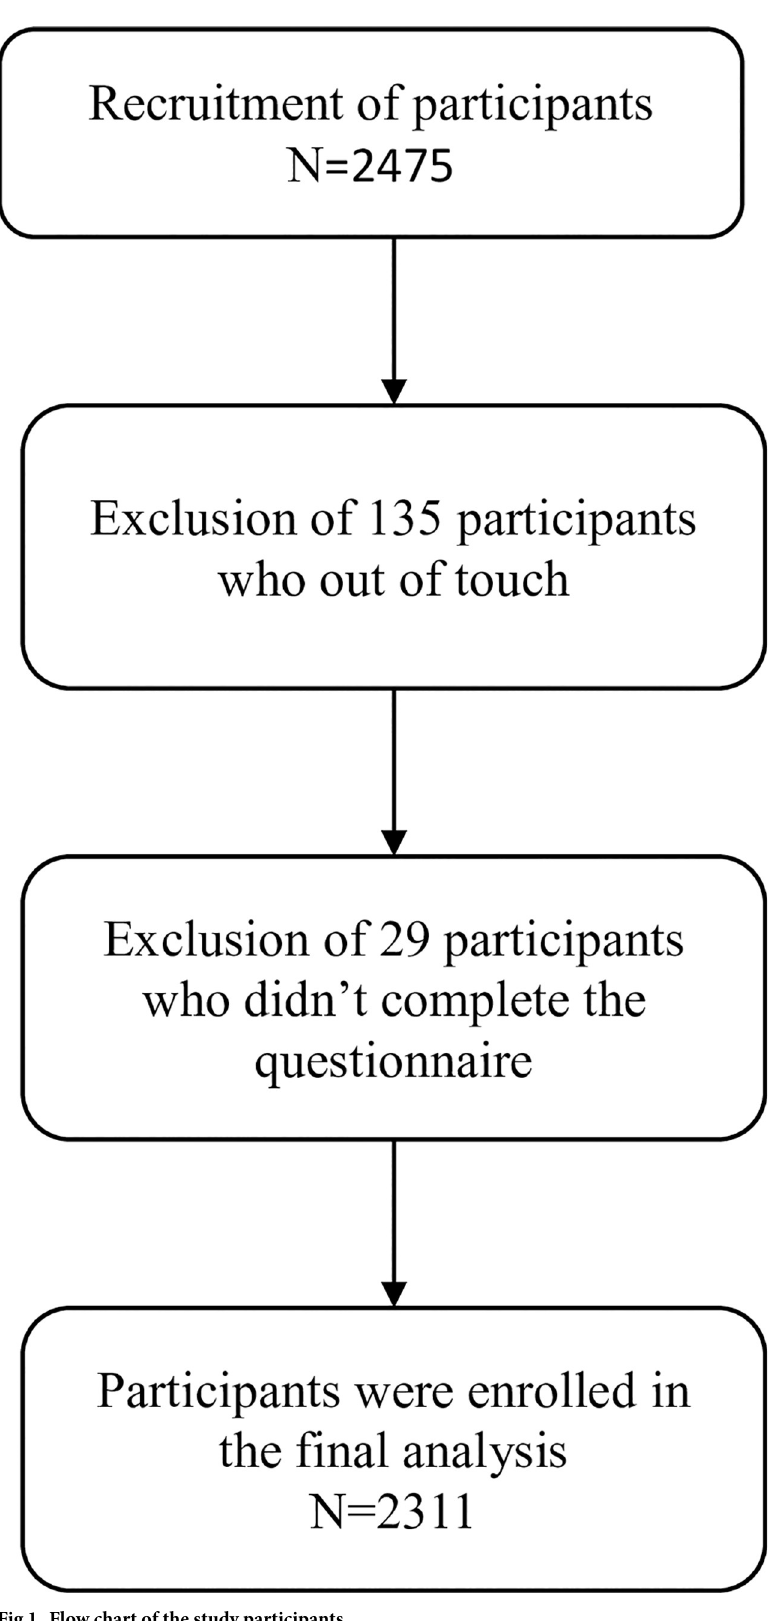
Fig 1. Flow chart of the study